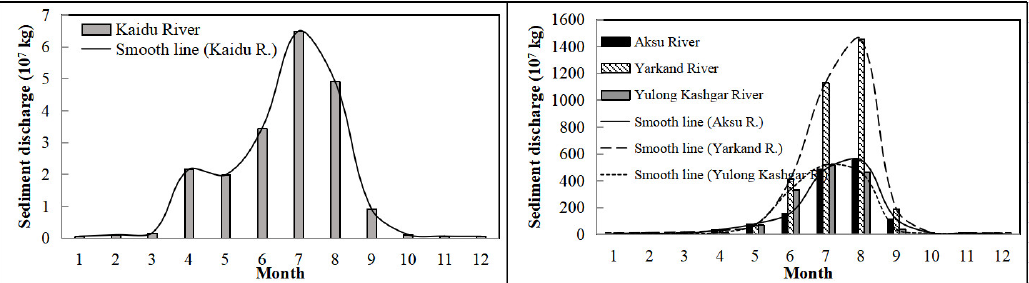
Figure 3. Intra-annual variation of sediment discharge at the main rivers of the